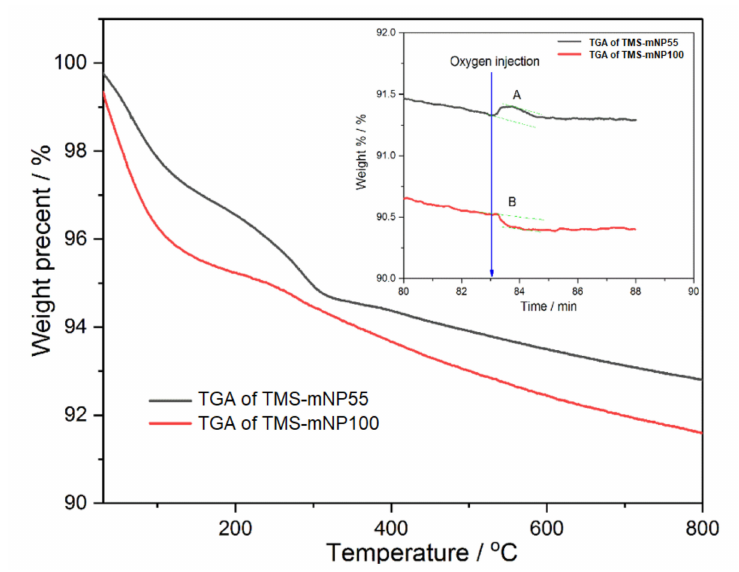
Figure 10. Thermogravimetric analysis (TGA) curve of A TMS-mNP55 and B TMS-mNP100.